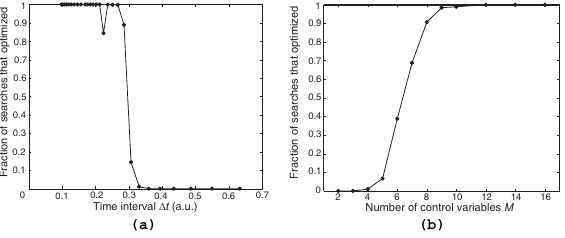
Fig. 4 Effect of control constraints on optimization: (a) The fraction of successful optimization searches versus the sampling time period (cid:129)(cid:129)(cid:129)t of the time discretization; (b) the fraction of successful optimization searches versus the number of control variables. Reproduced with permission from Ref. [52], (cid:13) C 2015